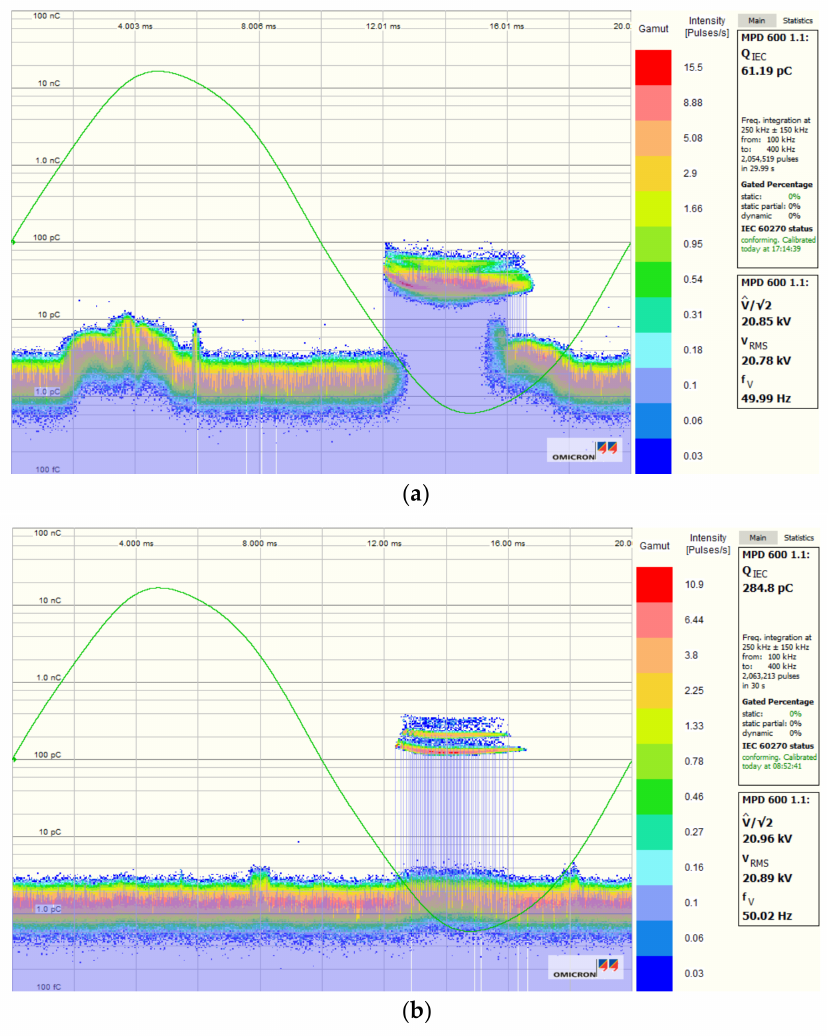
Figure 14. PD measurement results of sample C: ( a ) before and ( b ) after the 55th